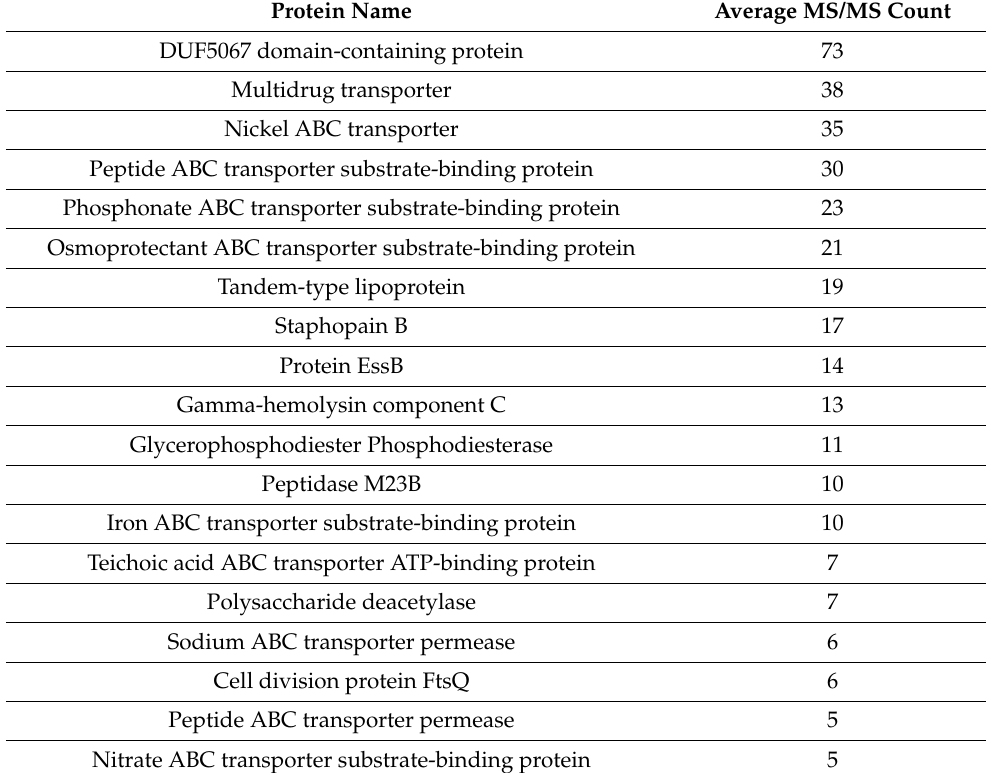
Figure 9. HSN584 effects on S. aureus ATCC 25923 protein expression. ( a ) Heat map depicting the expression of S. aureus proteins in the absence and presence of HSN584. ( b ) Visualization of S. aureus proteins regulation by HSN584 via a volcano plot. Table 3. Control group unique